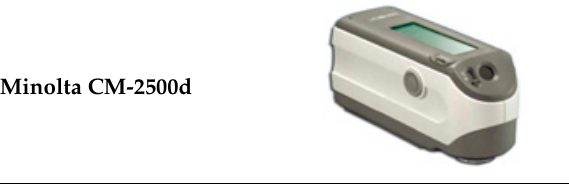
Table 3. Specifications of the spectrophotometer (Minolta CM-2500d).